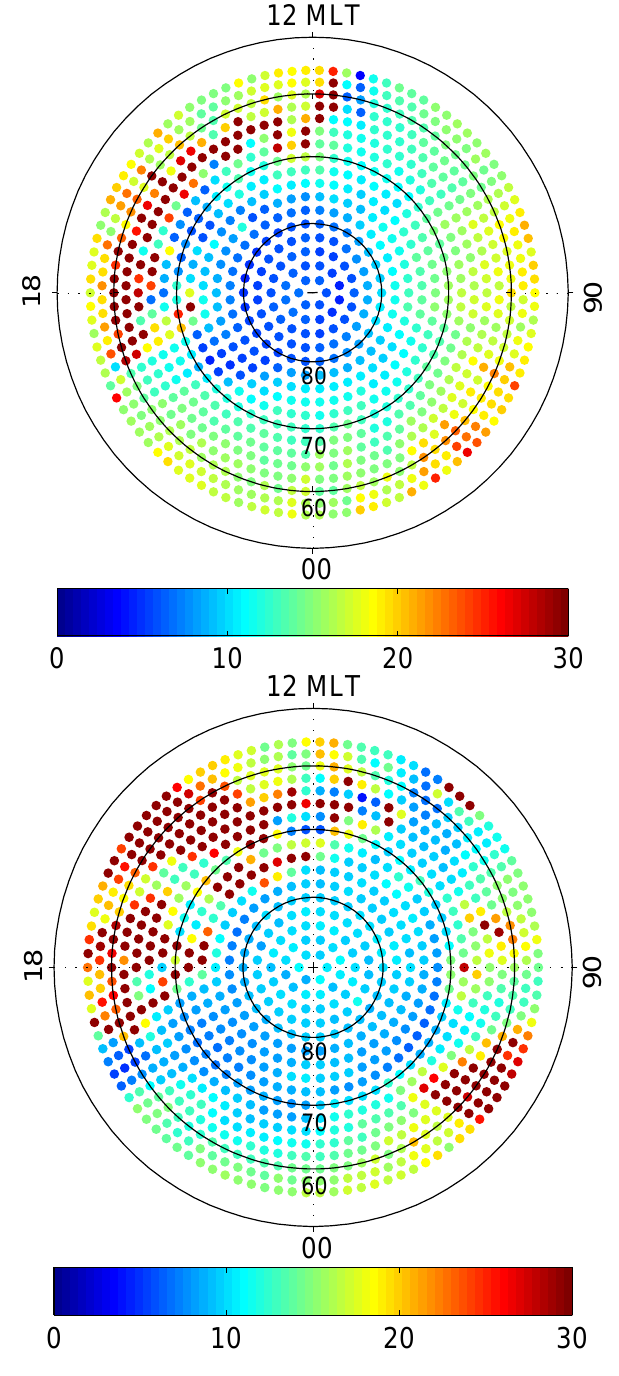
Fig. 5. Relative standard deviation of the estimated wind vector (in %) for each bin in Northern (top) and Southern (bottom) Hemi- sphere. The obtained values do not reflect the uncertainty of the measurements but the variability of the prevailing